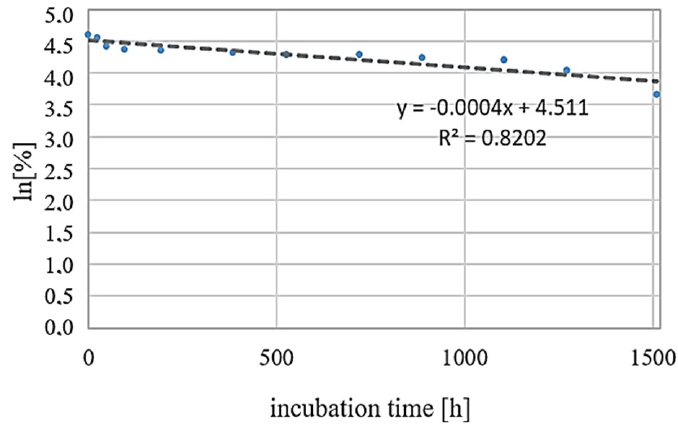
Figure 8. An example of ln[%] t =-kt+ln[%] 0 dependence for grapiprant solution incubated in 1M HCl at room temperature. Table 3. Values of the parameters of the curves ln[%] t = − kt + ln[%] 0 (acc. y = ax + b) and correlation coefficients ( r ) for solutions incubated at room temperature and 70 °C. Temperature